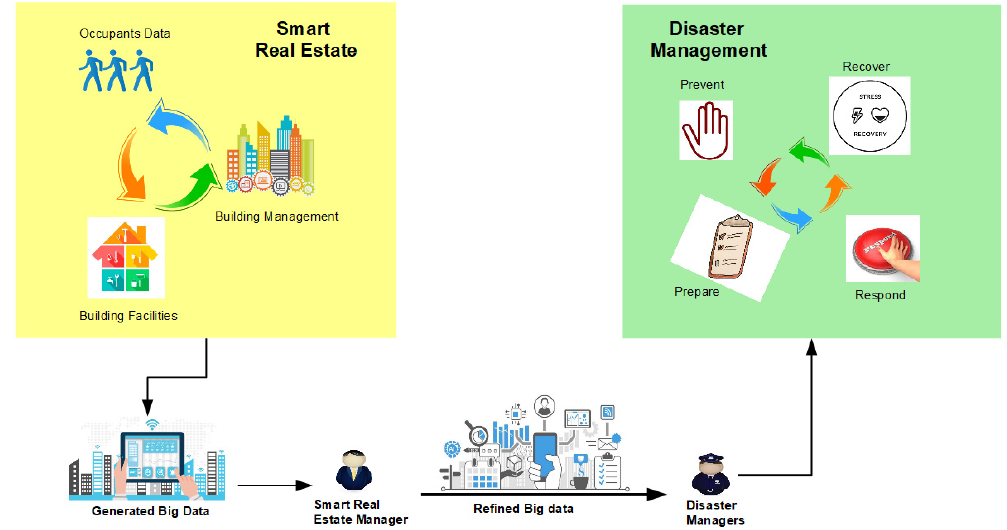
Figure 15. Smart real estate big data as an input to disaster management.